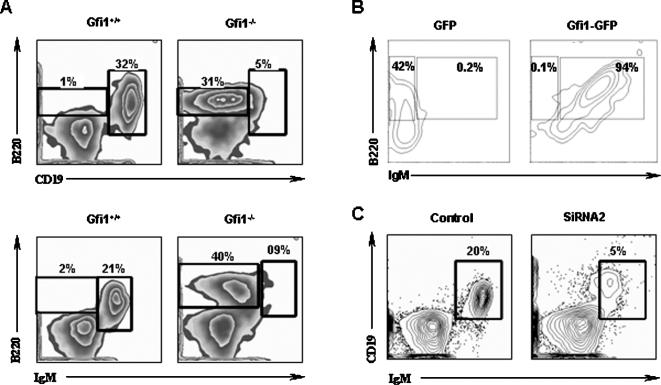
Defective in-vitro differentiation of Gfi1−/− B cells.A) FACS plot showing block in in vitro B cell development in the absence of Gfi1. HSC were differentiated using IL7 and SCF and analyzed for expression of B220 and CD19 (top panel) and for expression of B220 and IgM (bottom panel). Data are representative of 3 independent experiments. B) FACS plot indicating rescue of B cell differentiation upon retroviral gene transfer. LSK cells from Gfi1−/− mice were isolated and transduced with retroviral constructs encoding GFP or Gfi1-GFP. Transduced cells were cultured in the presence of SCF and IL7 for 14 days and GFP-positive cells were analyzed for expression of B220 and IgM. Data are representative of 2 independent experiments. C) FACS plot showing decreased in vitro B cell development upon knockdown of Gfi1 in HSC. HSC were transduced with lentiviral constructs encoding Gfi1 specific shRNA. Transduced cells were cultured in the presence of SCF and IL7 for 14 days and analyzed for expression of CD19 and IgM. Cells transduced with lentiviral backbone served as controls. Data are representative of 2 independent experiments.